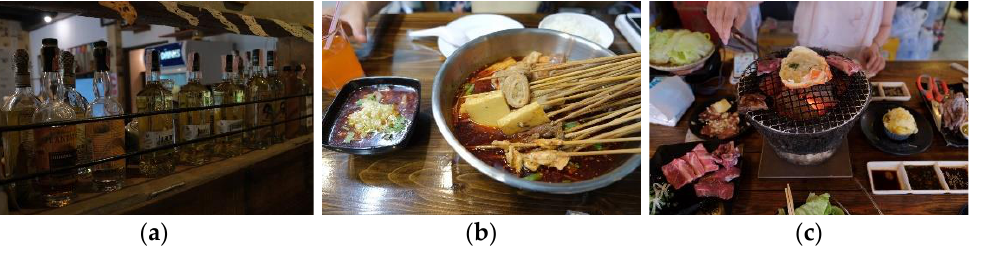
Figure 6. Typical images of overseas ethnic foodscape: ( a ) the interior setting of a Mexican restaurant; ( b ) the spicy food of a Chinese Szechuan restaurant; ( c ) a restaurant of Japanese barbecue.